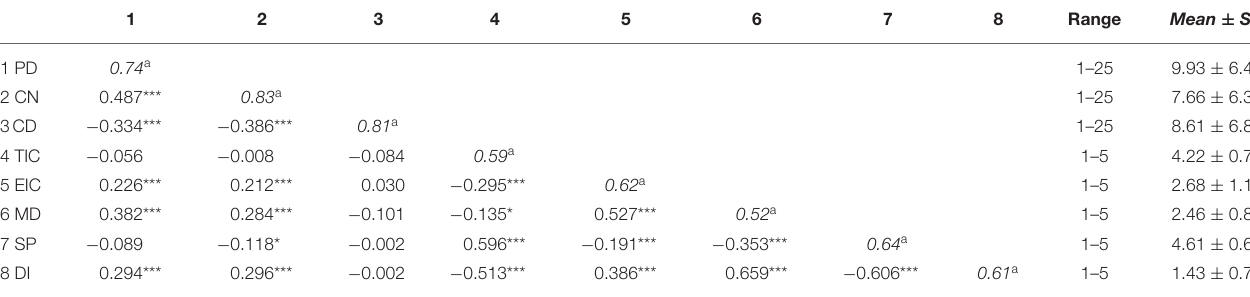
TABLE 2 | Inter-correlations, square roots of average variance extracted (AVE), means, and standard deviations of the study variables ( N =